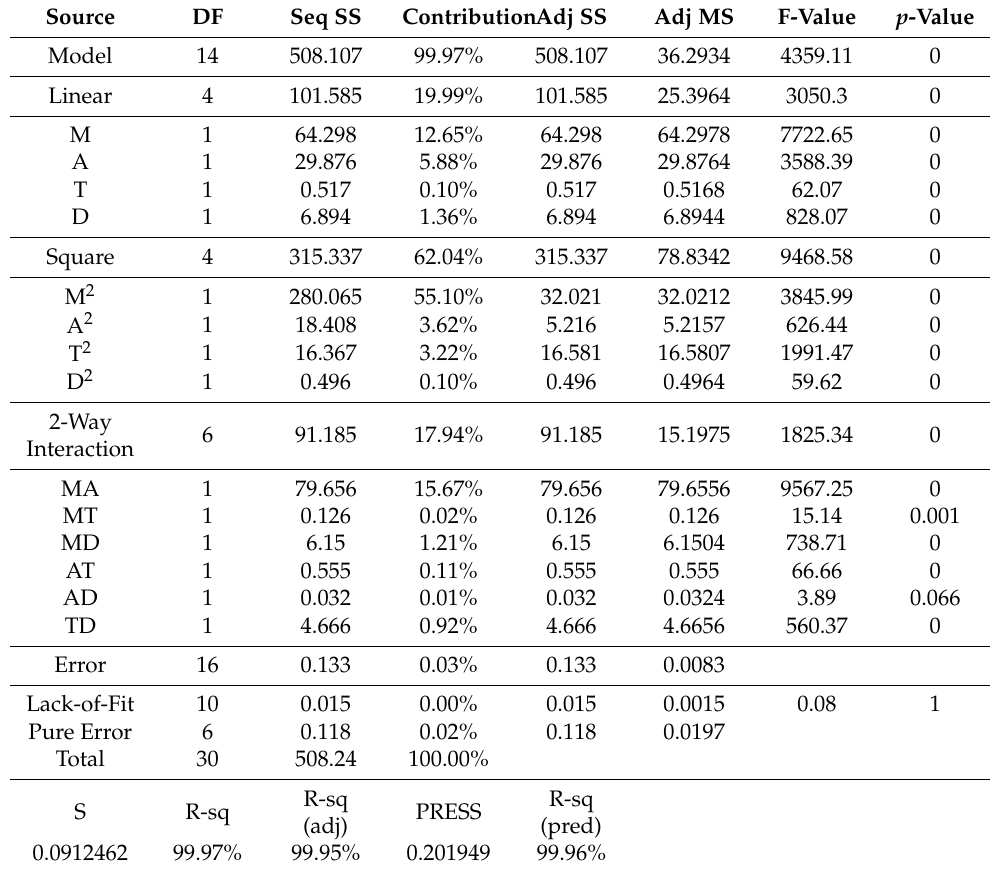
Table 10. The ANOVA test of the quadratic model for the acidity removal of the WCO as a function of the considered parameters